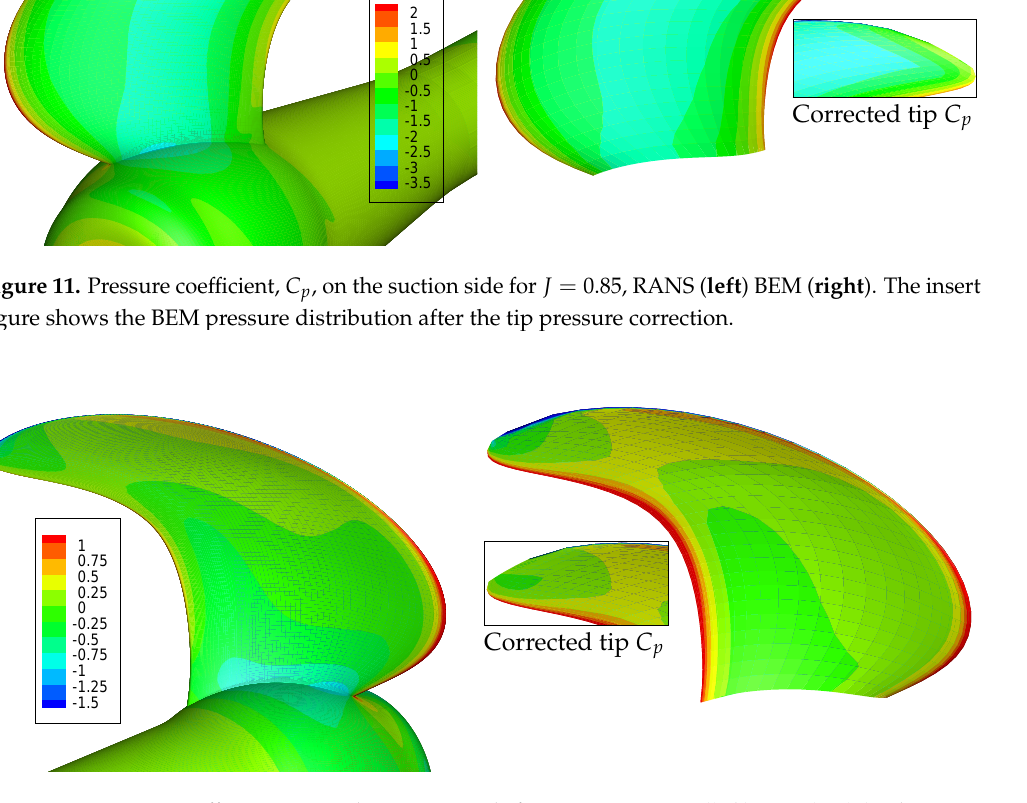
Figure 12. Pressure coefficient, C p , on the pressure side for J = 0.85, RANS ( left ) BEM ( right ). The insert figure shows the BEM pressure distribution after the tip pressure